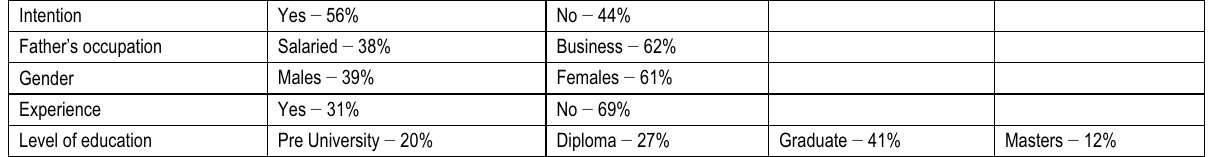
Table 3. Profile of respondents (N = 300)